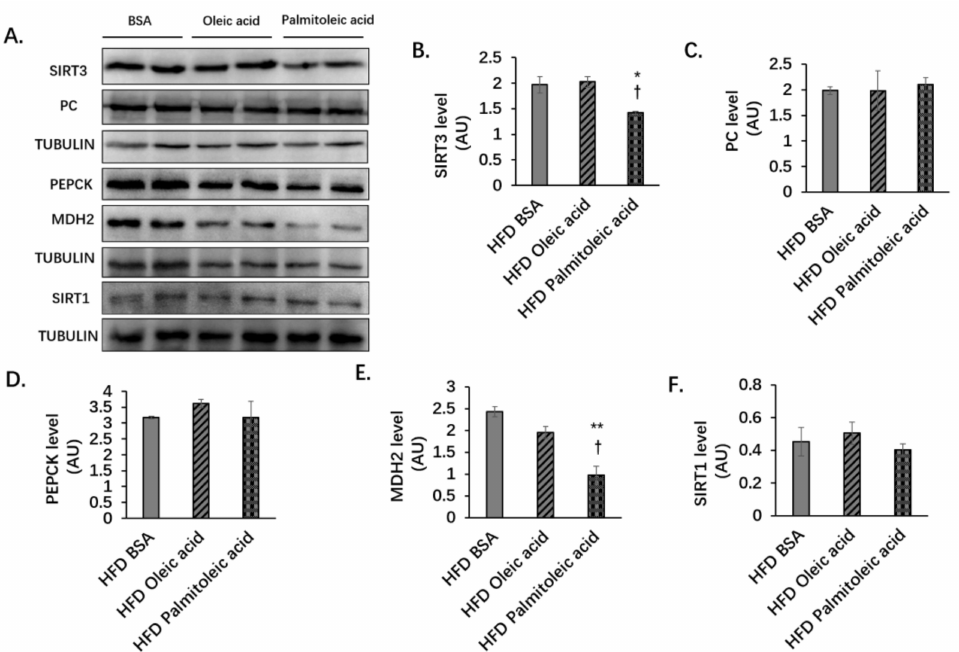
Figure 3. Palmitoleic acid reduced the expression of SIRT3 and MDH2 but did not change the protein levels of PC, PEPCK, and SIRT1 in the liver of mice under HFD. C57BL/6N male mice of 5–6 weeks of age were fed with HFD for 12 weeks. At the 13th week, BSA, oleic acid, or palmitoleic acid were administered intragastrically. At the 18th week, mice were euthanized, and liver tissues were collected. ( A ) Expression of SIRT3, SIRT1, and gluconeogenic enzymes in the liver of mice under HFD. Protein expression was detected using Western blot analysis. ( B ) Quantification of SIRT3 protein level. ( C ) Quantification of PC protein level. ( D ) Quantification of PEPCK protein level. ( E ) Quantification of MDH2 protein level. ( F ) Quantification of SIRT1 protein level. AU, arbitrary units. The data are mean ± s.e. (error bars). n = 4–6 mice per group. *, p < 0.05, **, p < 0.01, HFD BSA vs. HFD palmitoleic acid; †, p < 0.05, oleic acid vs. palmitoleic acid.